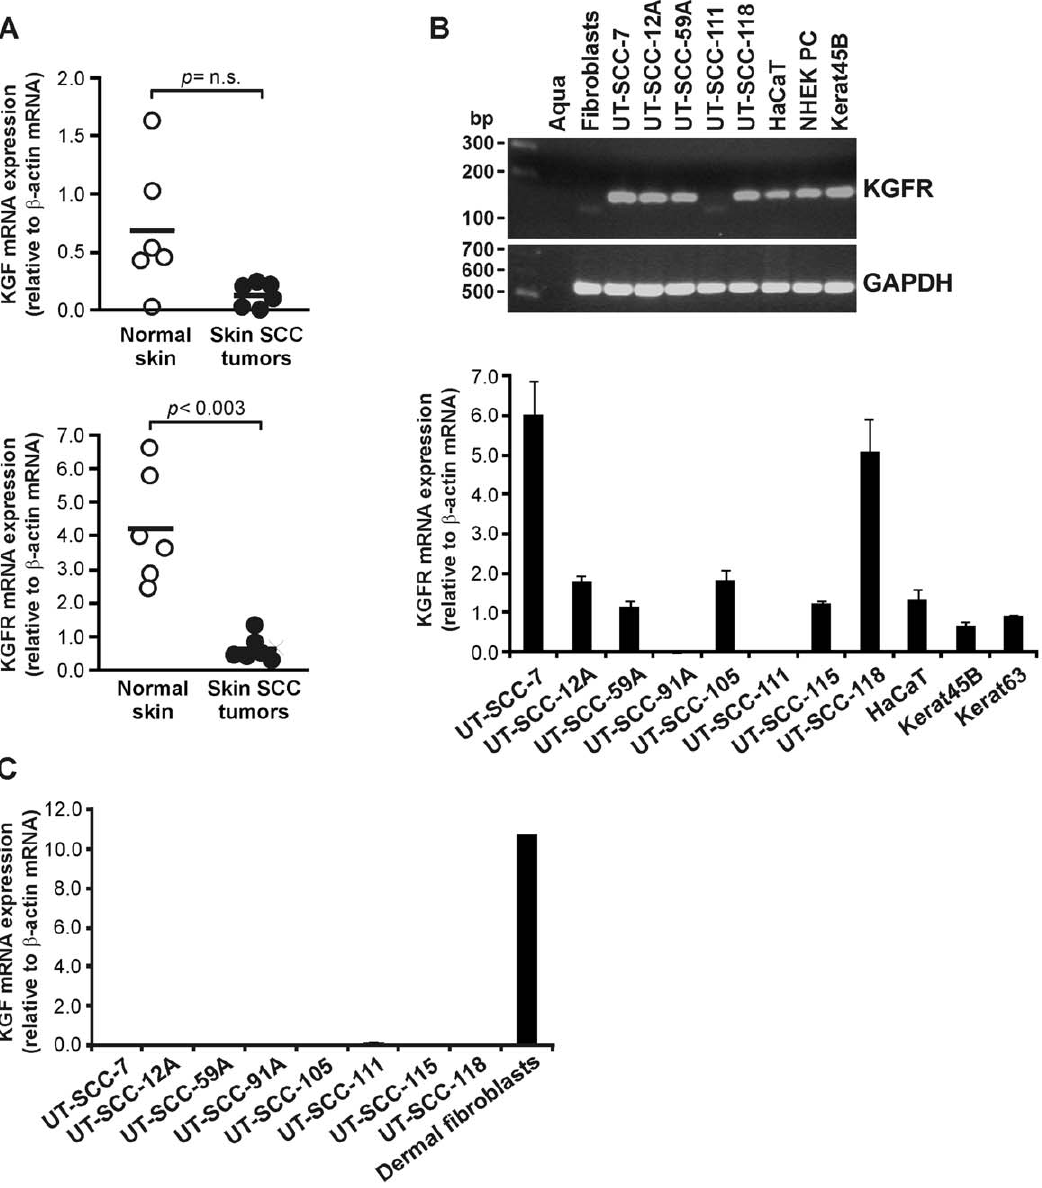
Figure 1. Expression of KGF and KGFR mRNA in cutaneous SCC tumors and cell lines. ( A ) Cutaneous SCC tumor tissue samples (n=6) and normal skin samples (n=6) were analyzed for KGF (upper panel) and KGFR (lower panel) mRNA levels by qPCR. The results were normalized for b - actin mRNA levels in each sample. A dot represents the mean of duplicate analysis of one sample. Statistical analysis with independent samples T-test (n.s., not significant). ( B , upper panel) Human skin SCC cell lines (UT-SCC-7, -12A, -59A, -111, -118), HaCaT cells and normal epidermal keratinocytes (NHEK PC, Kerat45B) were analyzed for the expression of KGFR mRNA using RT-PCR. RNA from normal human skin fibroblasts served as a negative control. Amplification of a fragment of housekeeping gene GAPDH transcript was used as a loading control. ( B , lower panel) KGFR mRNA expression was quantified in human skin SCC cell lines (UT-SCC-7, -12A, -59A, -91A, -105, -111, -115, and -118), HaCaT cells and normal epidermal keratinocytes (Kerat45B, Kerat63) with qPCR (n=3–4). ( C ) KGF mRNA expression was quantified in human skin SCC cell lines (UT-SCC-7, -12A, -59A, -91A, -105, -111, -115, and -118), and normal human dermal fibroblasts with qPCR (n=3–4). doi:10.1371/journal.pone.0033041.g001 keratinocytes: MMP13 (matrix metalloproteinase-13, collage- nase-3), MATN2 (matrilin 2), CXCL10 (chemokine (C-X-C motif) ligand 10, IP-10), and IGFBP3 (insulin-like growth factor binding protein 3).